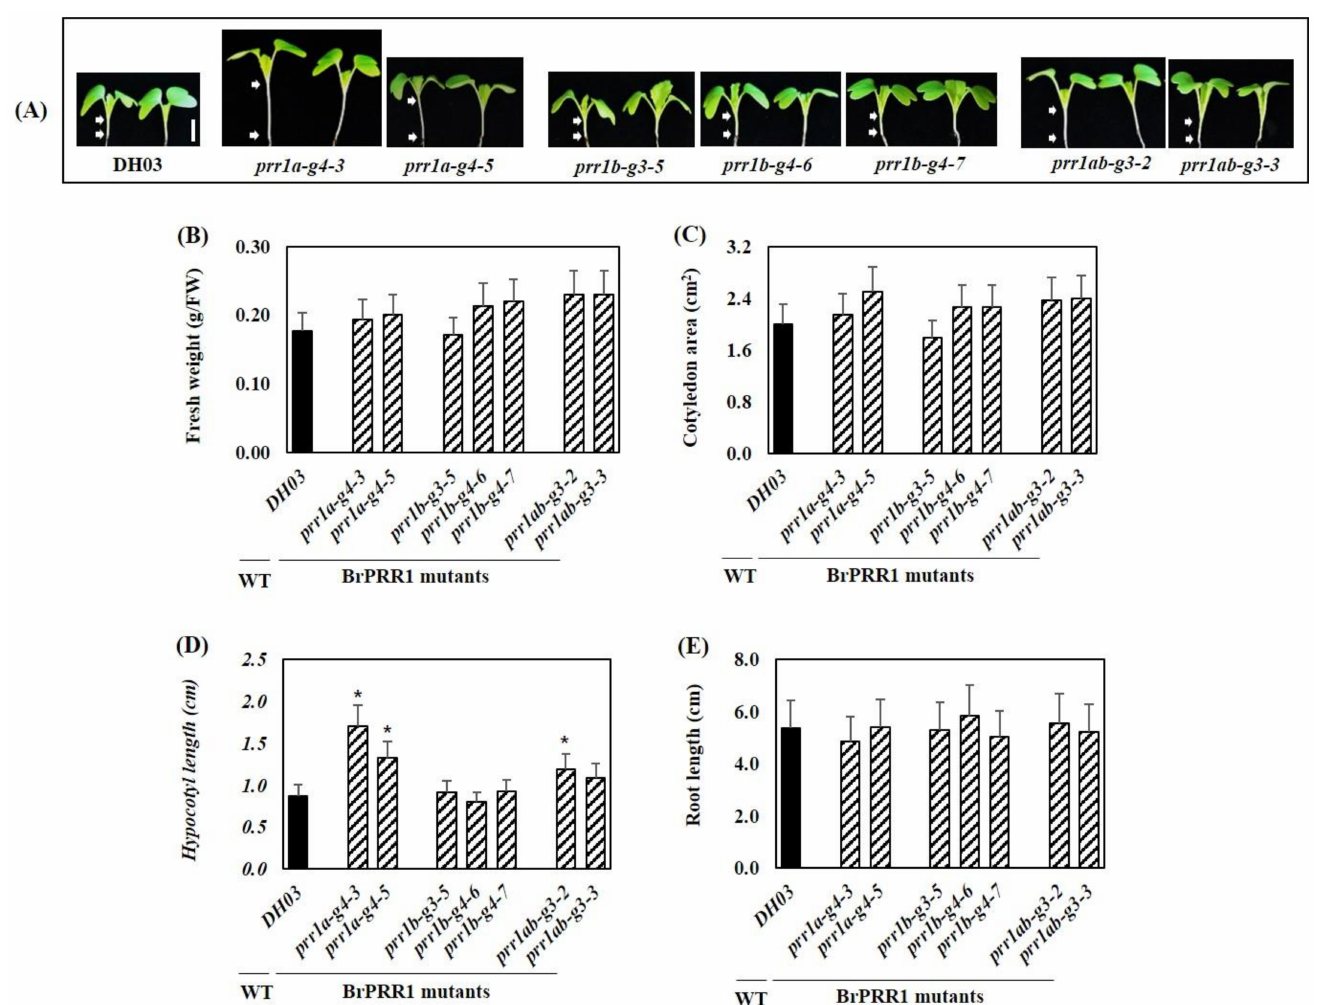
Figure 5. Phenotypes of B. rapa seedlings in DH03 and BrPRR1a , 1b , and 1ab mutants grown under a 16 h/8 h light/dark cycle. Two representative images of each mutant of 8-day-old Chinese cabbage seedlings are shown ( A ). Bar = 1 cm. White arrows indicate the hypocotyl area. Fresh weight ( B ), cotyledon area ( C ), hypocotyl length ( D ), and root length ( E ) of 8-day-old Chinese cabbage sprouts. Values are the means of three biological replicates, and error bars indicate standard deviation (SD). * p < 0.05 compared with wildtype control